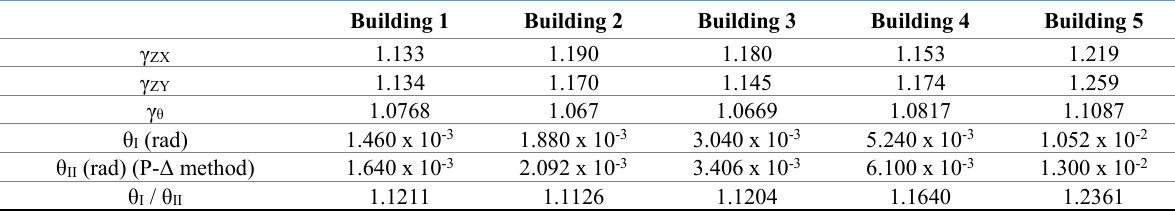
Table 6. γ θ coefficient calculation and comparison with P- Δ method (second analysis).